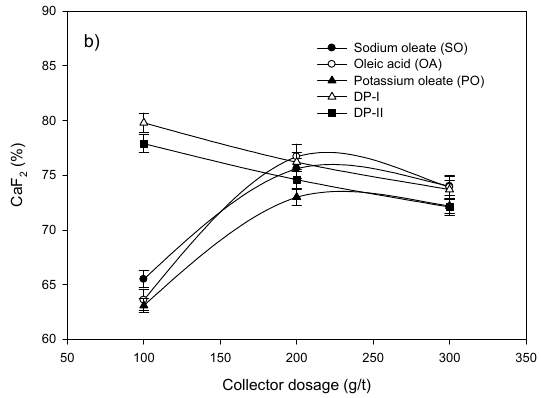
Figure 5. Effect of the collector dosage on the CaF 2 grade in the mechanical cell ( a ) and pneumatic cell ( b ) froth flotation.